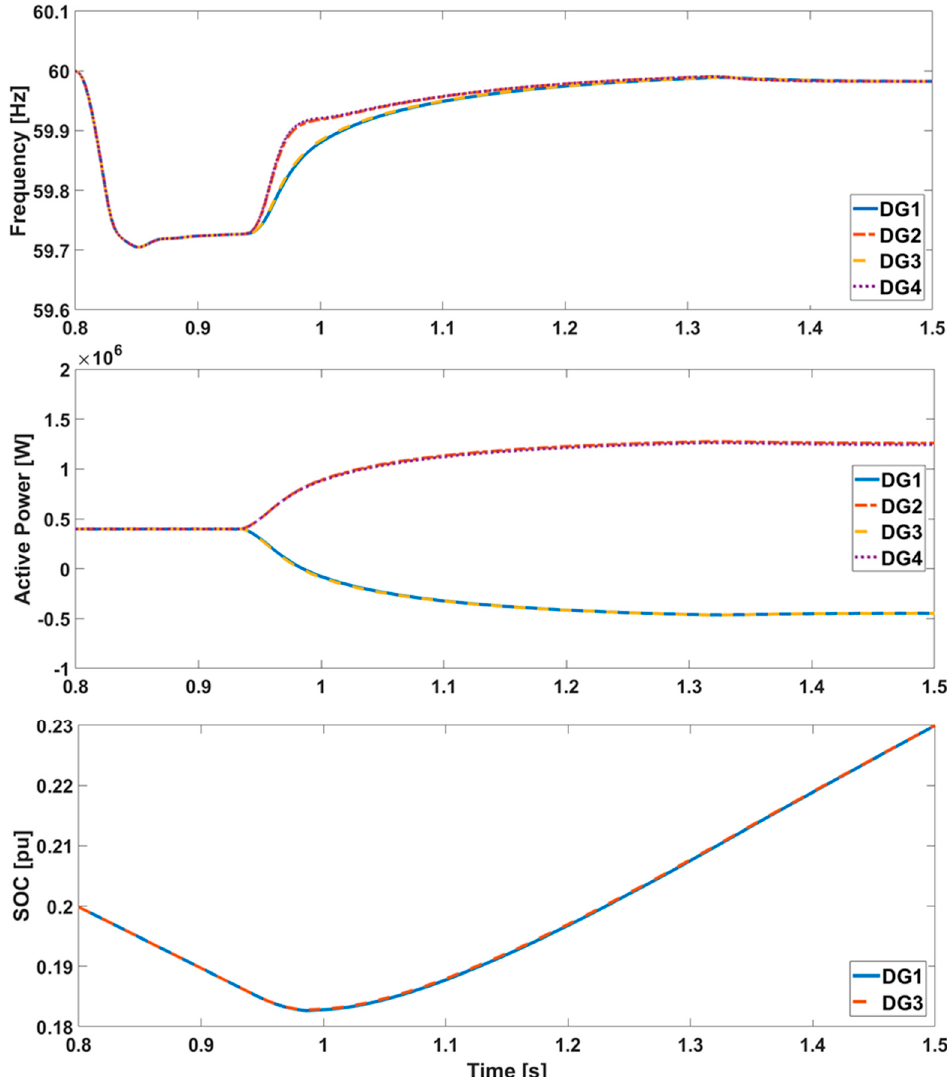
Figure 7. SOC restoration results when the SOCs are same.